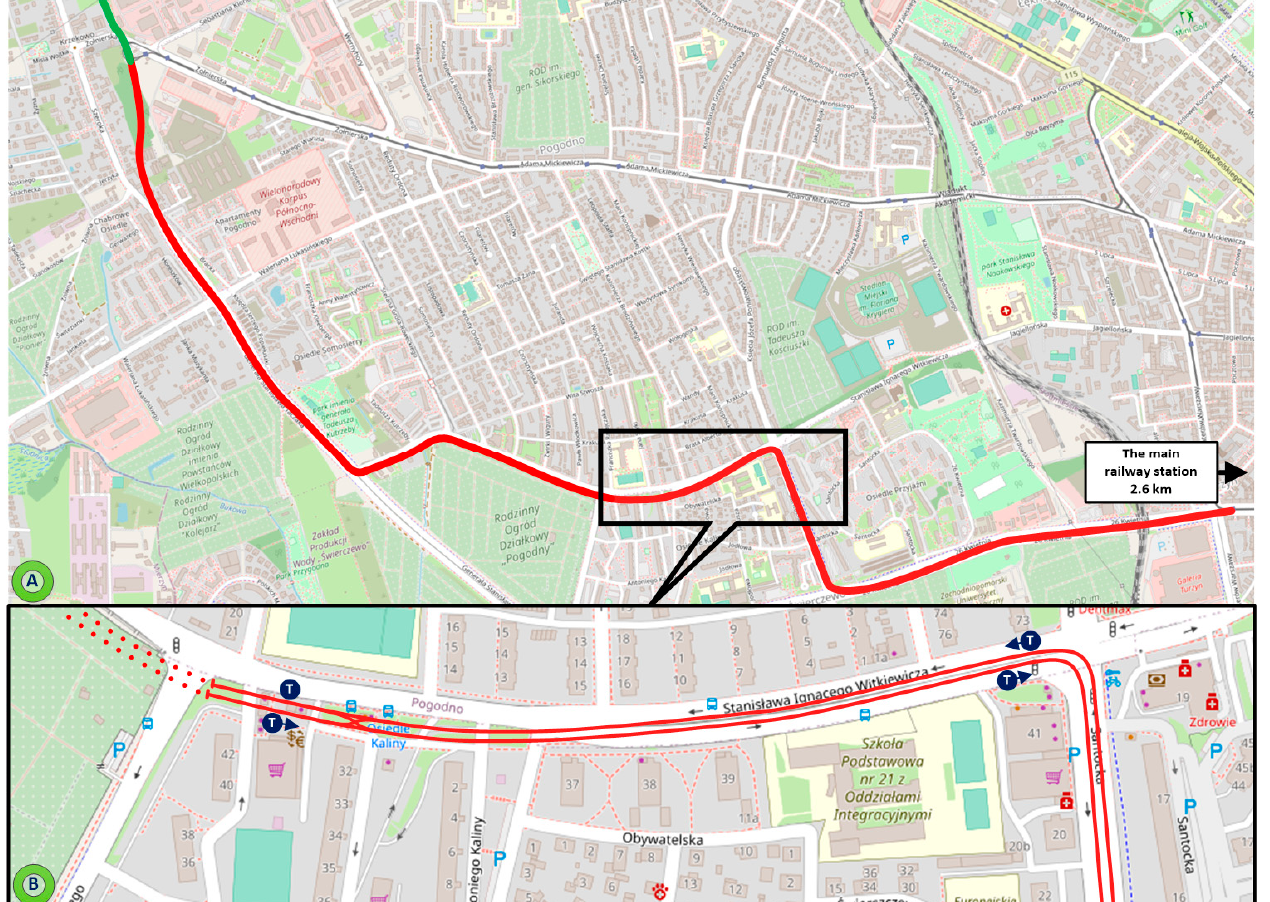
Figure 17. Application of the bi-directional tram, enabling phased development (construction of the tram route to the Krzekowo tram loop on Ż o ł nierska Street in Szczecin) (own study based on open- the tram route to the Krzekowo tram loop on ˙Zołnierska Street in Szczecin) (own study based on streetmap.org).